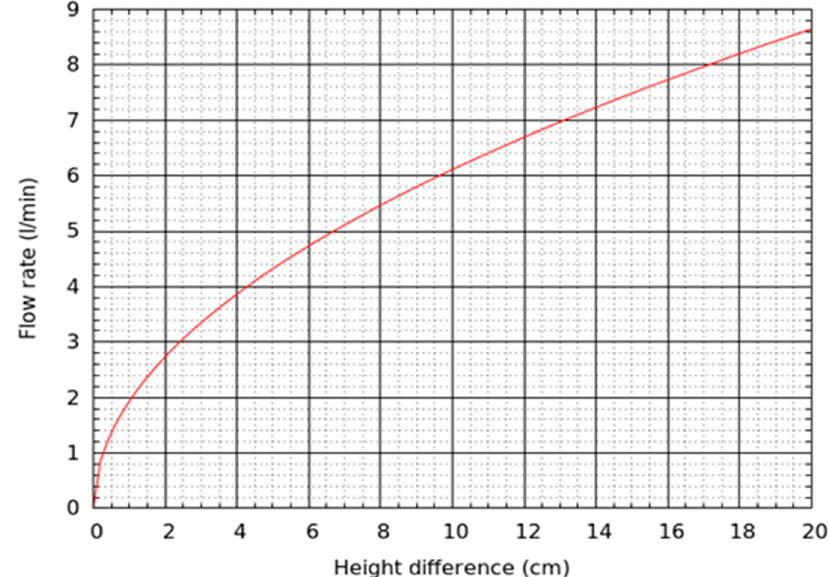
Figure 1. Calibration chart for an orifice plate provided to students.